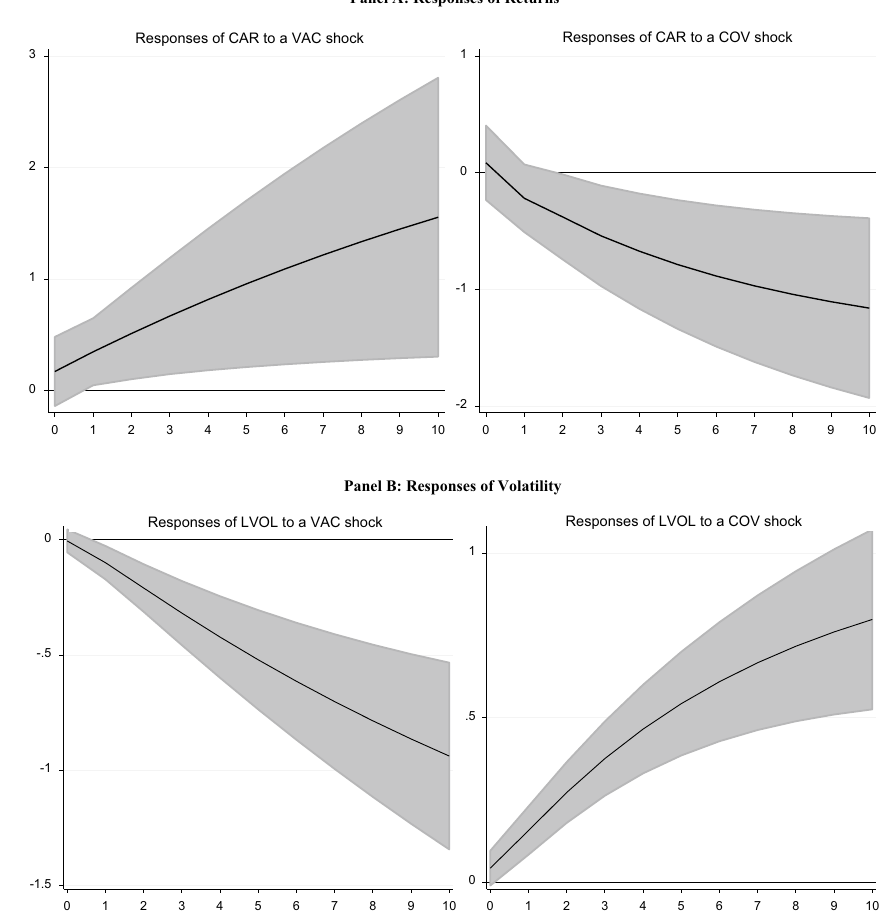
Fig. 3 Impulse Response Analysis Results. Note The figures show the cumulative orthogonalized impulse response functions. The shaded areas represent two standard deviation confidence intervals. Moreover, the shaded areas represent 95% confidence intervals. A Monte Carlo simulation with 1,000 draws is used to obtain the confidence